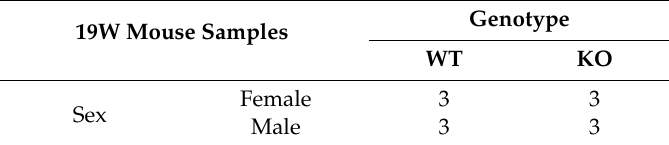
Table A4. Number of 19W mouse samples from GSE58271 that were included to determine processes that contribute to tumor progression from 19W towards